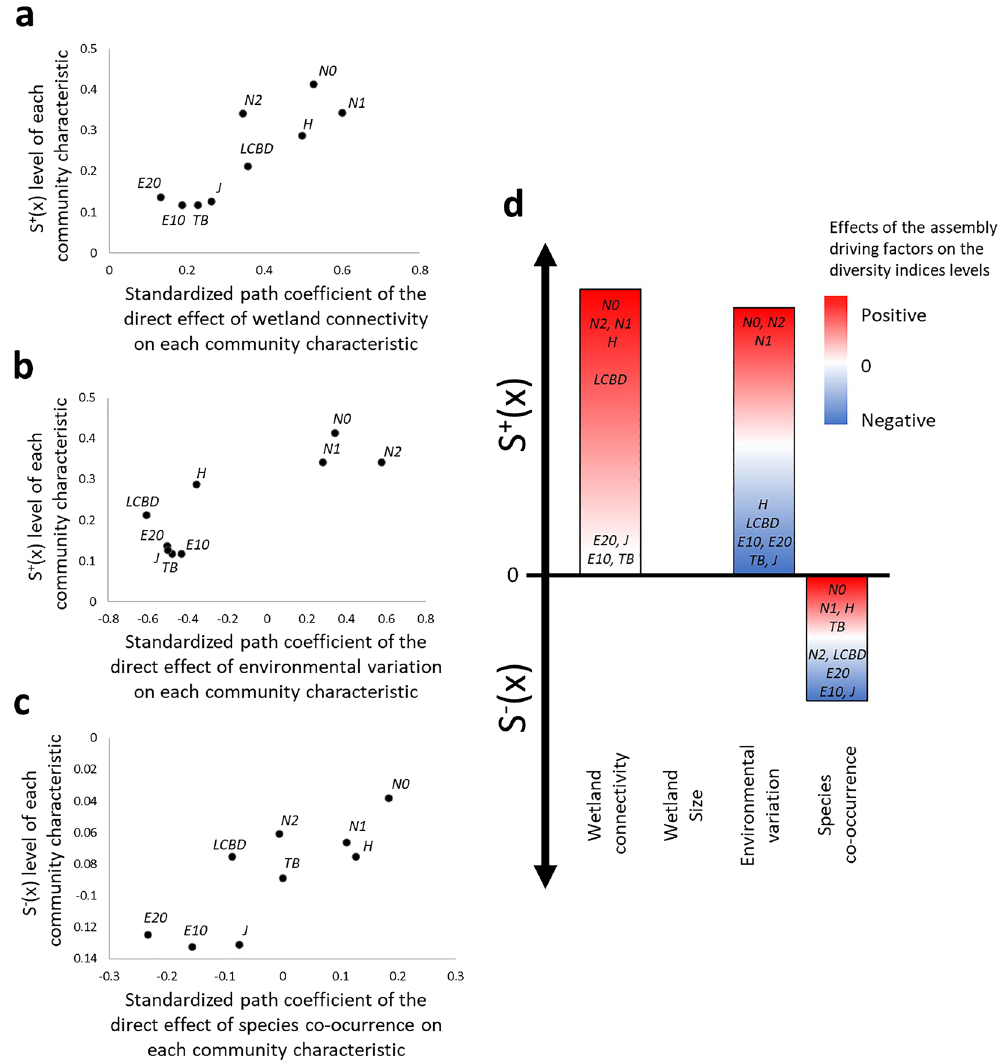
Figure 2. Relationships between the effects of ecological factors on community characteristics and the levels of spatial autocorrelation displayed by the latter. ( a , b, c ) Biplots for significant relationships of the autocorrelation levels of the community metrics by the amplitude of ecological factor’s path coefficients. Dots indicate the position of each community parameter. ( d ) Representation of the ecological factor effects. Bar sizes are proportional to detected effects. The colors indicate whether increases in autocorrelation are mediated by positive or negative effects of ecological factors on diversity indices. Positive effects are shown in red, negative in blue, and null in white. For instance, both wetland connectivity and environmental variation increased S + (x) of diversity indices that they positively influenced (i.e., N0 , N1 , N2 and H ). S + (x) and S - (x) refer to positive and negative spatial autocorrelations, respectively. N0 : Richness; H : Shannon entropy; N1 : Shannon diversity; N2 : Simpson diversity; E10 : Shannon evenness; E20 : Simpson evenness; J : Pielou’s evenness, TB: Total biomass and LCBD: Local Contribution to